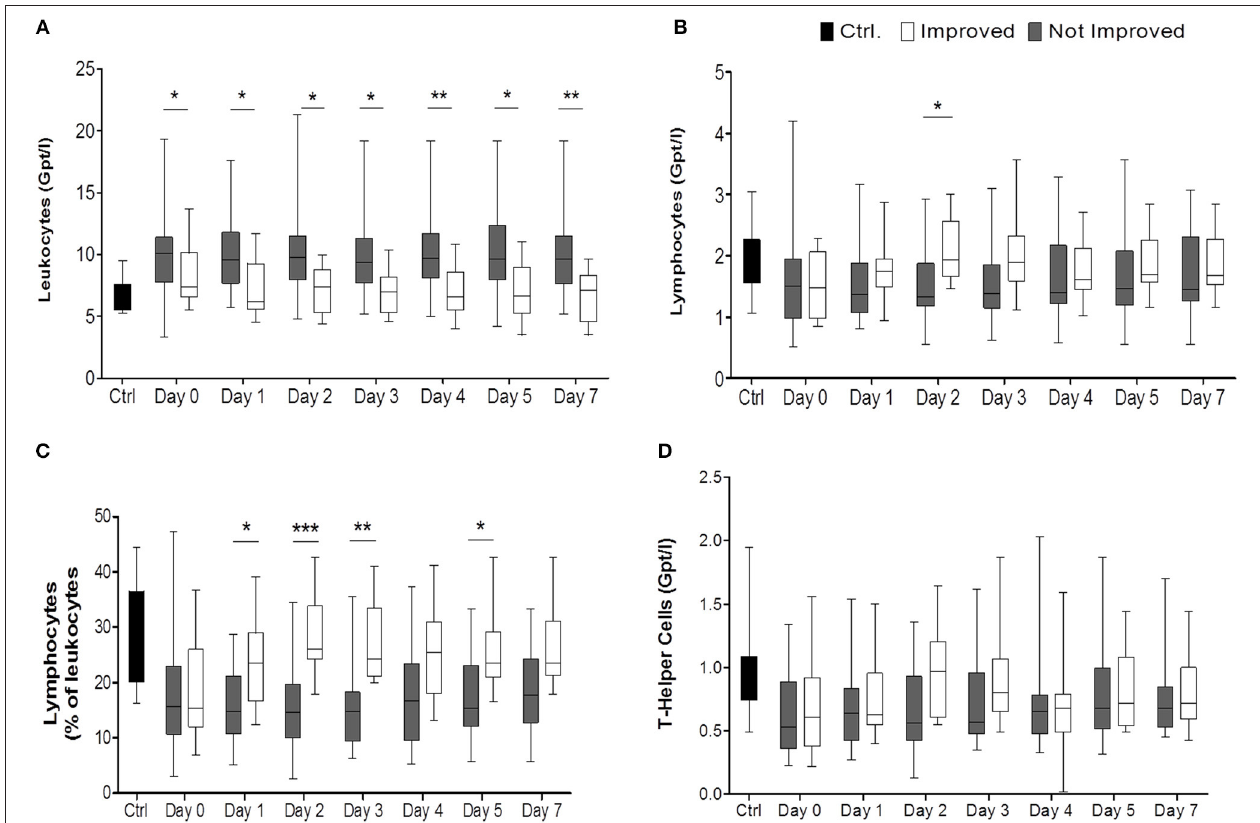
FIGURE 2 | Comparison of improved patients (white bars) vs. non-improved patients (gray bars) on the day of stroke unit admission (day 0), days 1, 2, 3, 4, 5, 7, while healthy control patients are given in black bars. In (A) the absolute numbers of leukocytes (Gpt/l) (n imp = 13, n non − imp = 26), in (B) absolute numbers of lymphocytes (Gpt/l) and in (C) relative numbers of lymphocytes (%) are shown. Absolute T helper cells (Gpt/l) are given in (D) . * p < 0.05; ** p < 0.01; *** p < 0.001; Box and whiskers (Min–Max) are given (n imp = 12, n non − imp =